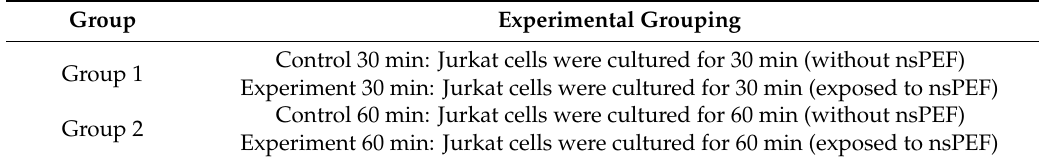
Table 8. Experimental